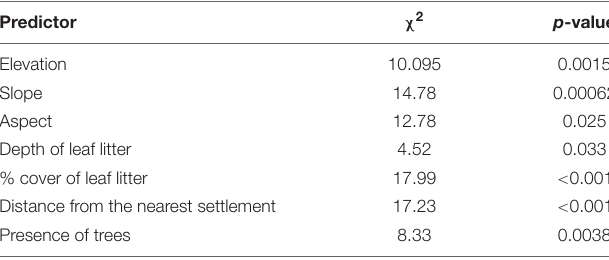
TABLE 2 | Estimates and statistics for the final model predicting the probability of observing barking deer, according to the GLM models. Predictor χ 2 p